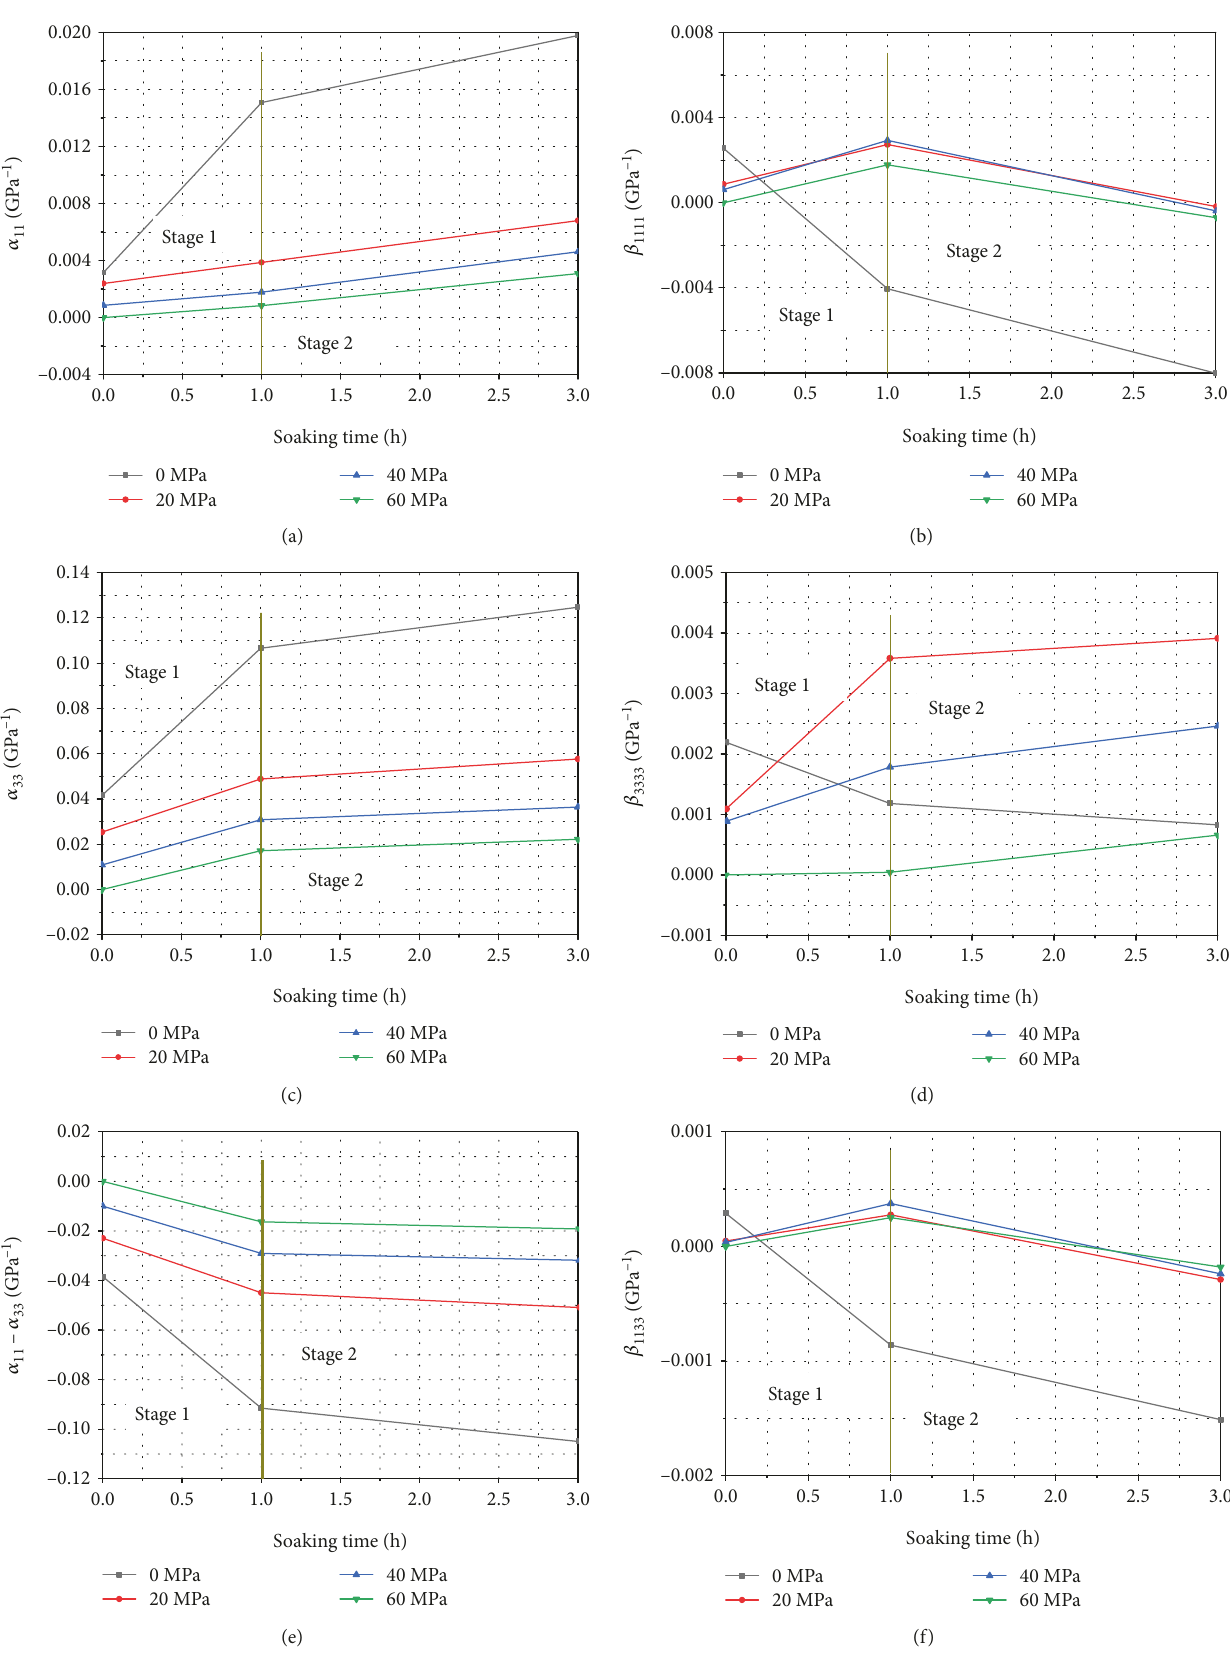
Figure 10: The relationship of damage parameters of shale and soaking